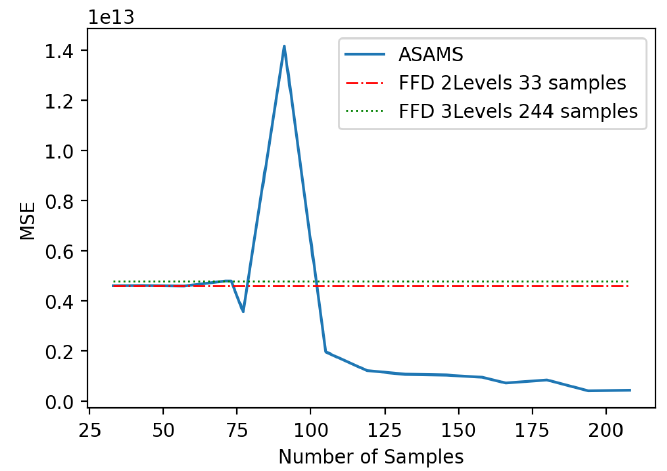
Figure 15. Interest region MSE comparison of the magnetic circuit.